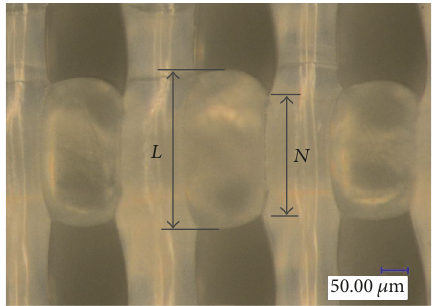
Figure 3: The neck length and the width of the bonding area. shown in Figure 3. 𝑁 represents the neck length of the bonding area, and 𝐿 means the width of the filament. But the value 𝑁 can not represent the bonding degree between the adjacent filaments alone due to the difference of layer thickness which also can change the neck length. So the neck length rate 𝑥 = 𝑁/𝐿 is utilized to reflect the bonding degree ignoring the effect caused by layer thickness. The rate 𝑥 is also listed in Table